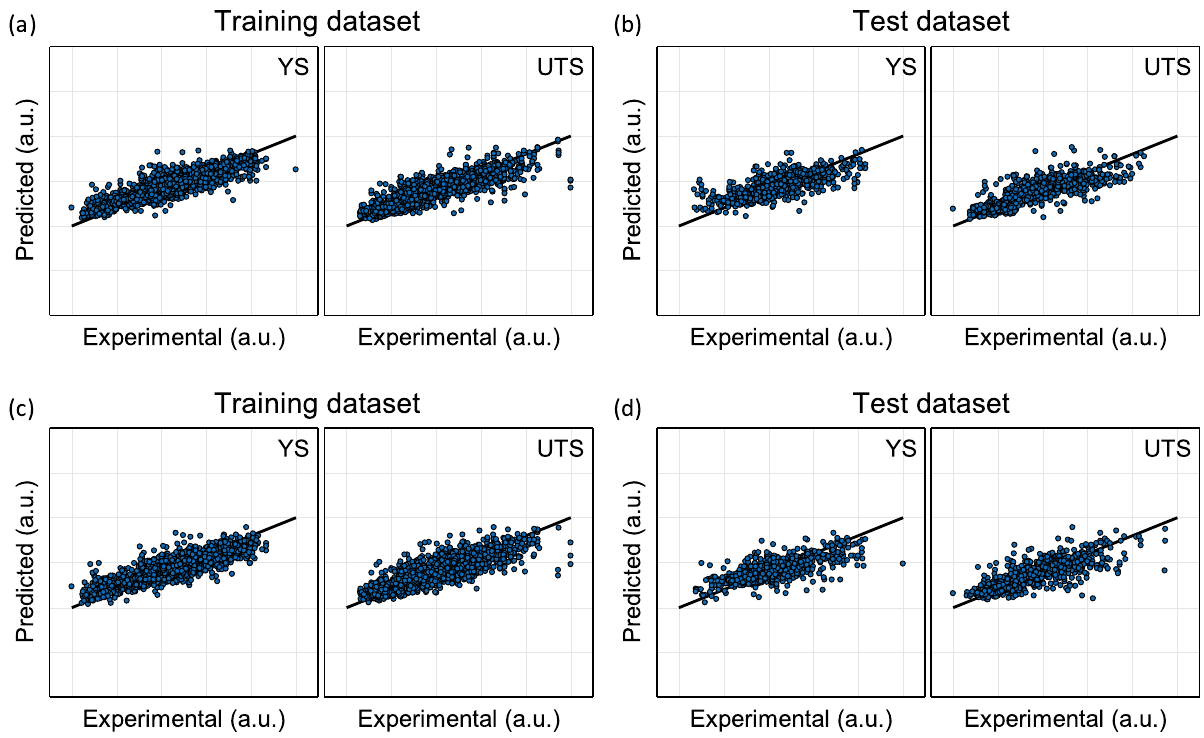
Figure 4. The predicted output versus the real output for ( a ) the training dataset, ( b ) the hold-out test dataset for a 16-input-feature DNN, ( c ) the training dataset, and ( d ) the hold-out test dataset for an 8-input-feature